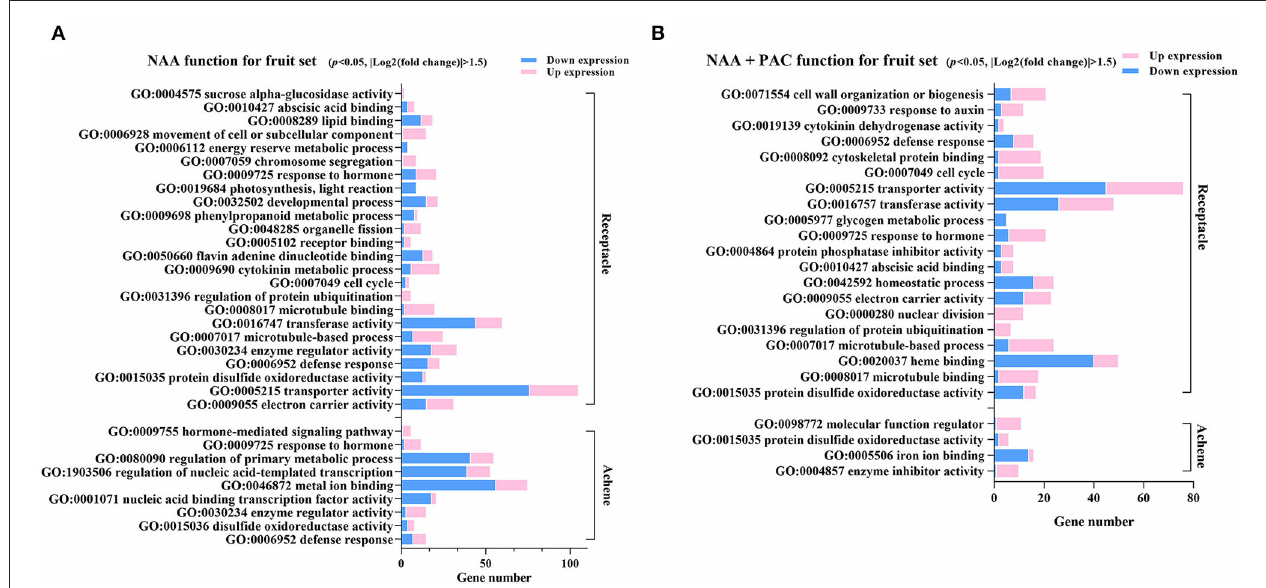
FIGURE 5 | Enriched GO terms identified in a3henes and receptacles under NAA and NAA + PAC treatment. (A) Functional enrichment of GO terms of differential expressed genes responding to NAA treatment. DEGs for receptacles and achenes were analyzed, respectively. (B) GO terms for genes influenced by NAA + PAC. The up- or downregulated genes are noted in different colors. P < 0.05, |log2(fold change)| >